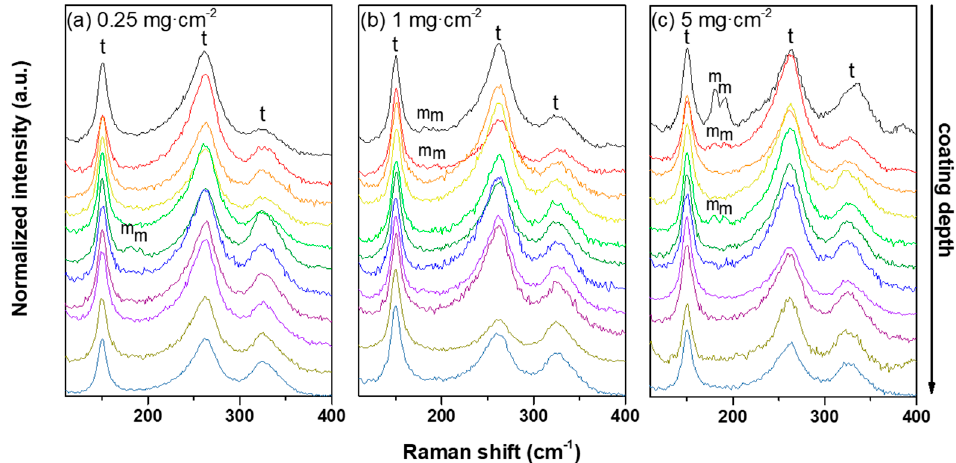
Figure 6. Raman spectra in the cross-sections of the standard 8YSZ coatings with CMAS deposits of ( a ) 0.25 mg·cm − 2 , ( b ) 1 mg·cm − 2 , and ( c ) 5 mg·cm − 2 annealed in air at 1250 °C for 1 h.